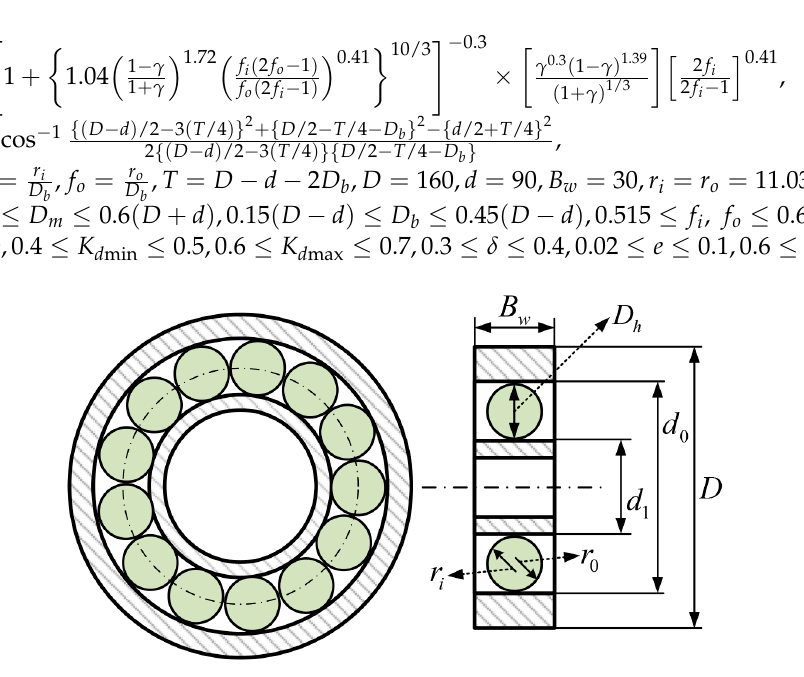
Figure 15. Schematic illustration of rolling element bearing design problem.